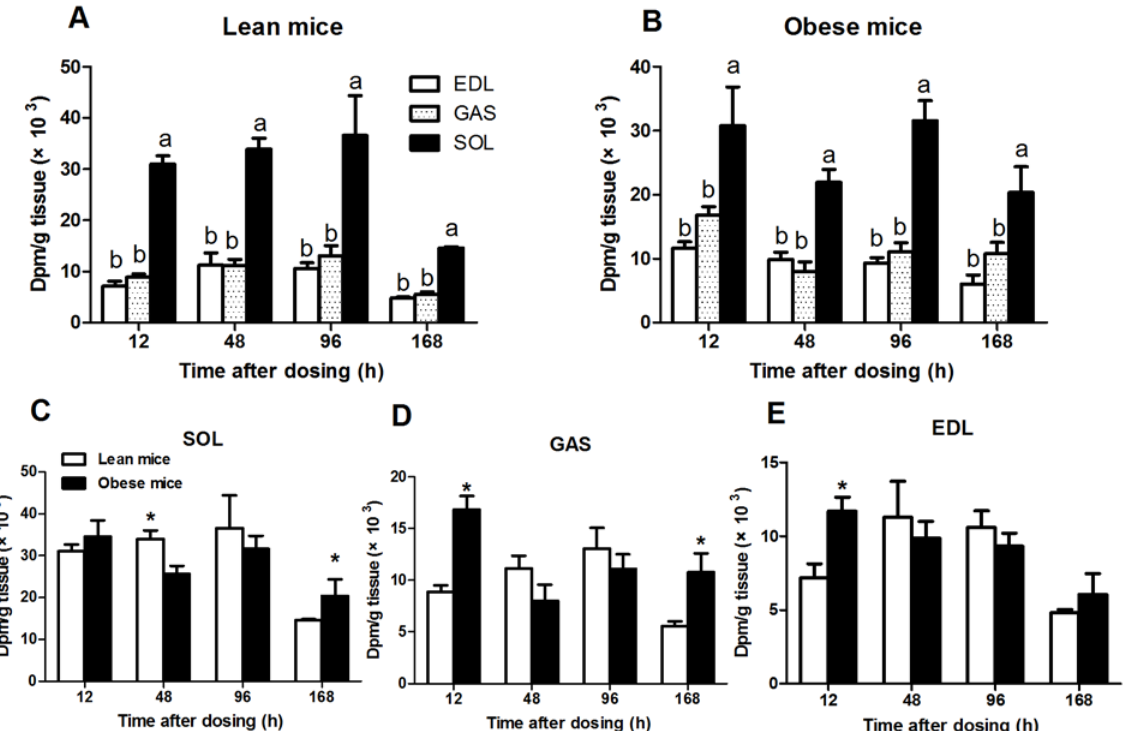
Fig 3. The concentration of 14 C-label (dpm/g tissue) in the EDL, GAS and SOL from lean mice (A) and obese mice (B). Comparative study of the 14 C-label concentration (dpm/g tissue) in the EDL (C), GAS (D) and SOL (E) between lean and obese mice. The data are presented as the mean ± SEM (n = 3). Different letters indicate significant differences between different muscle types at a particular time point ( P < 0.05). Asterisks ( * ) indicate significant differences between lean and obese mice at a particular time point ( P < 0.05). EDL, extensor digitorum longus; GAS, gastrocnemius; SOL, soleus.